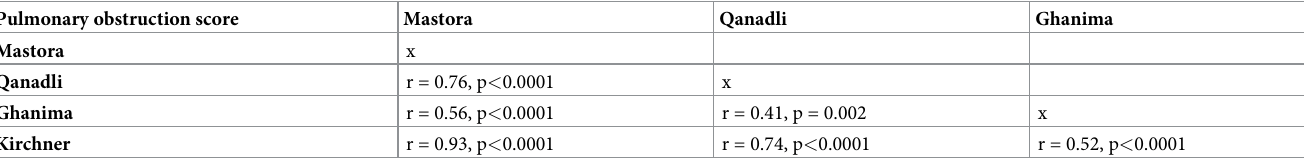
Table 3. Spearman’s correlation analysis of the investigated pulmonary obstruction